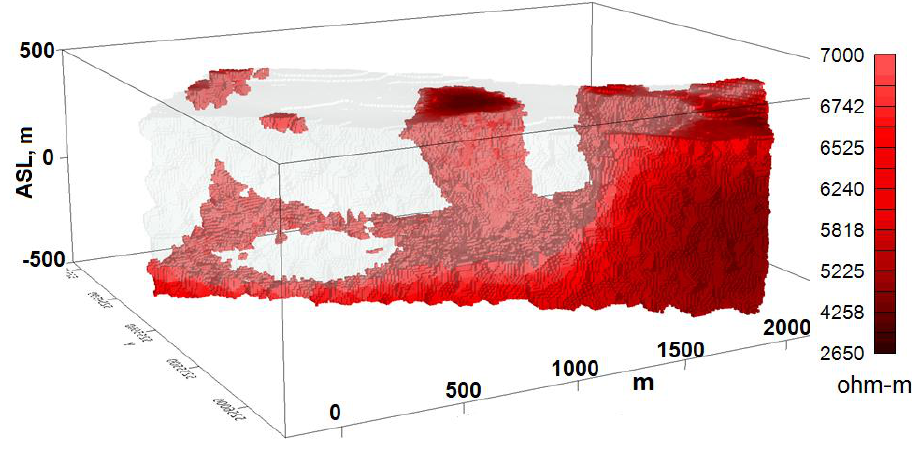
Figure 9. Conductive volumes of resistivity-depth model derived from 3D inversion (Geotexera Inc.). KL − 22 kimberlite pipe.